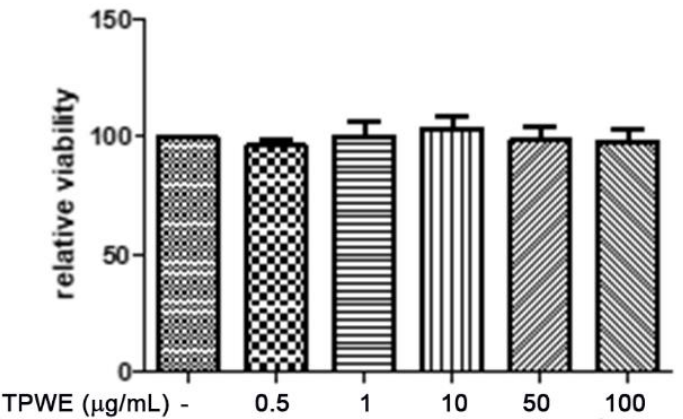
Figure 7. The null effect induced by Tanacetum parthenium (TPWE: 0.5–100 µg/mL) on the viability of the hypothalamic HypoE22 cell line evaluated using an MTT test.